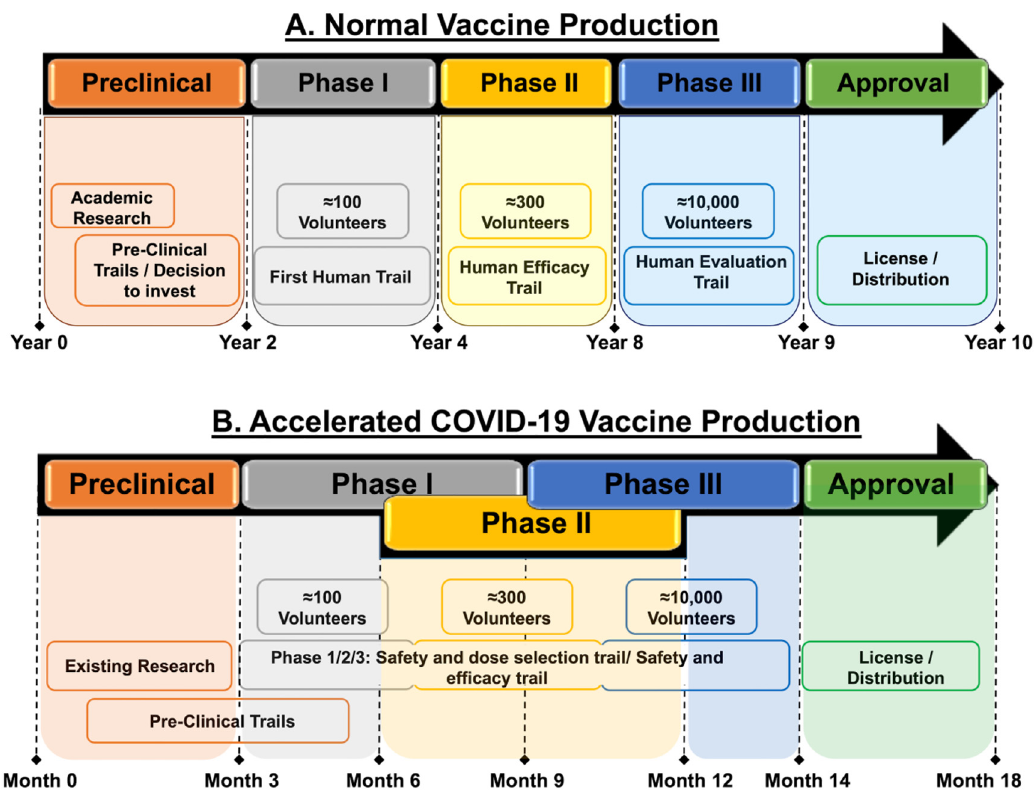
Figure 2: Phases of vaccine production in the normal (non-pandemic) versus accelerated pandemic COVID-19 threat. (A) Normally, it takes approx. 10 years for the approval of a single vaccine. (B) In the COVID-19 pandemic situation, the time period has been shortened to 18–20 months for the